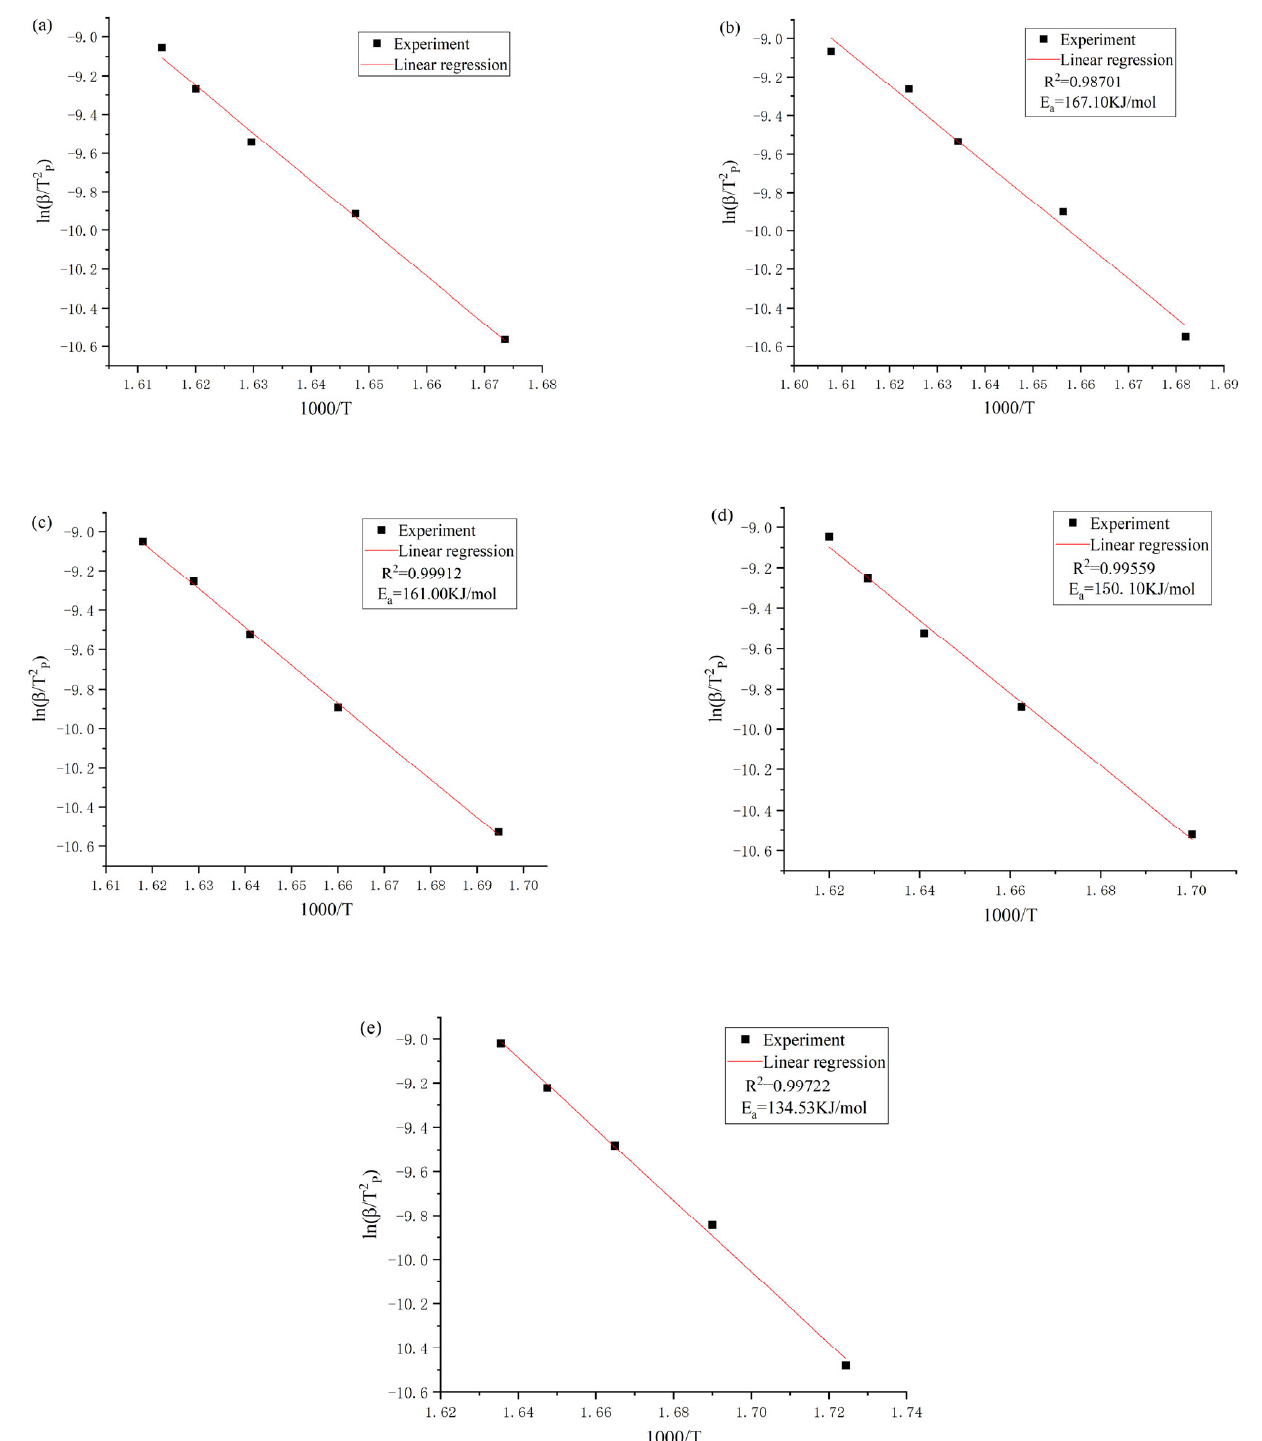
Figure Figure 5. Fitting results of the Kissinger method for [Emmim][NO 3 ] ( a ), [Bmmim][NO 3 ] ( b ), [Hmmim][NO 3 ] ( c ), [Om ‐ mim][NO 3 ] ( d ) and [Dmmim][NO 3 ] ( e ).